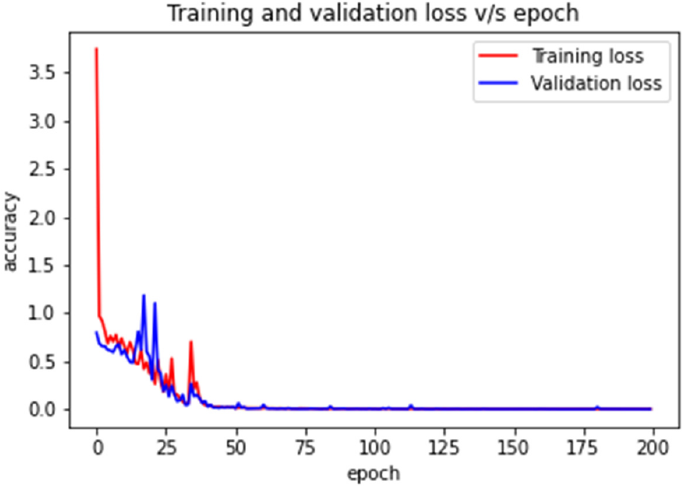
Figure 8. Scalogram representation for various loading conditions for healthy and faulty state under the same operating conditions of 10% speed.